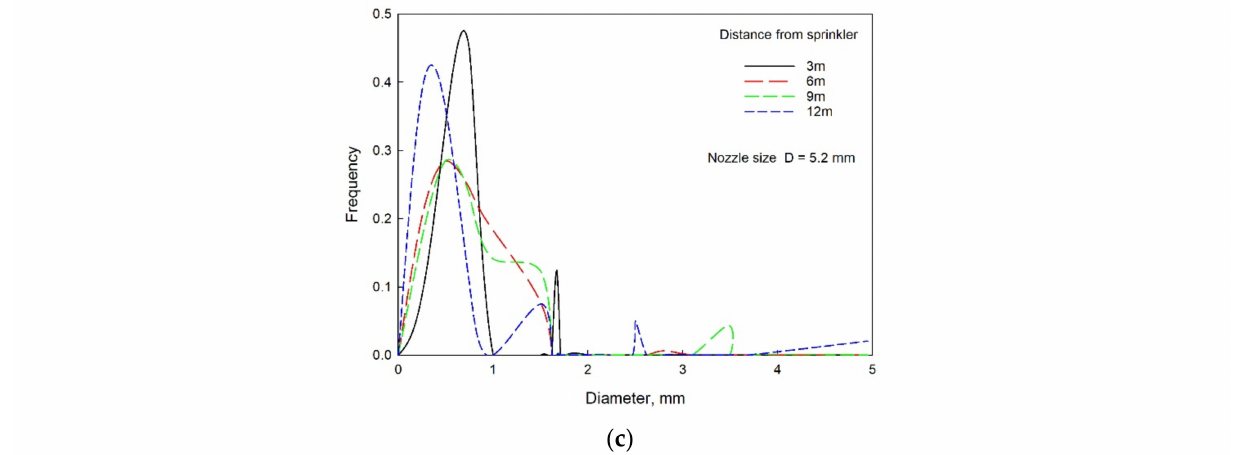
Figure 6. Relationships between frequency and droplet diameter with a nozzle size of ( a ) D = 4.4 mm, ( b ) D = 4.8 mm and ( c ) D = 5.2 mm under 250 kPa of